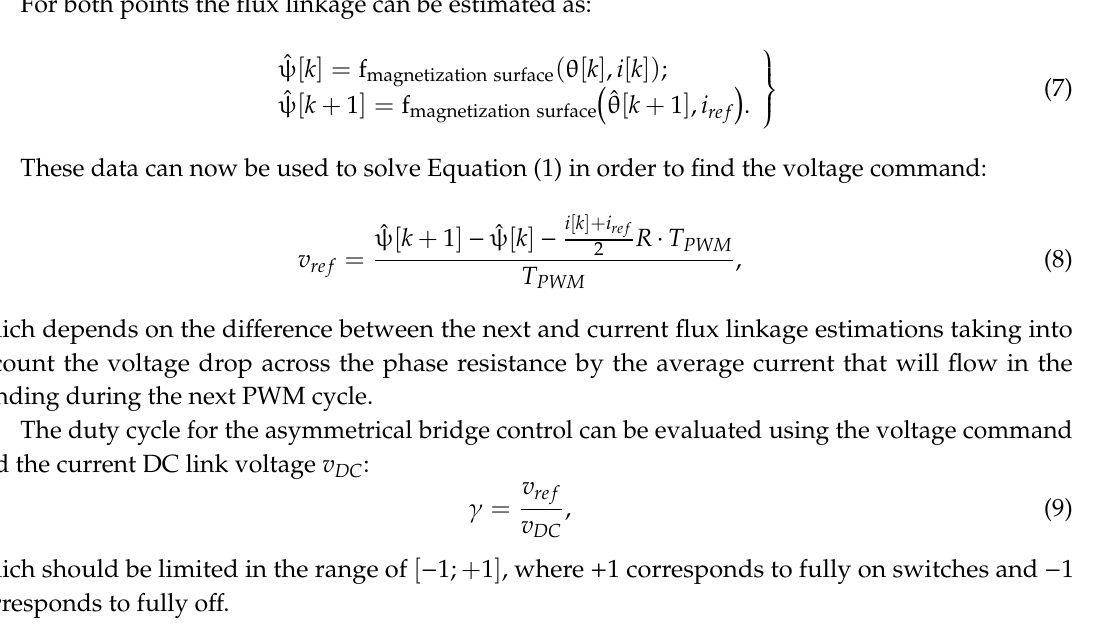
Figure 4. Transient during a single pulse-width modulation (PWM) cycle.